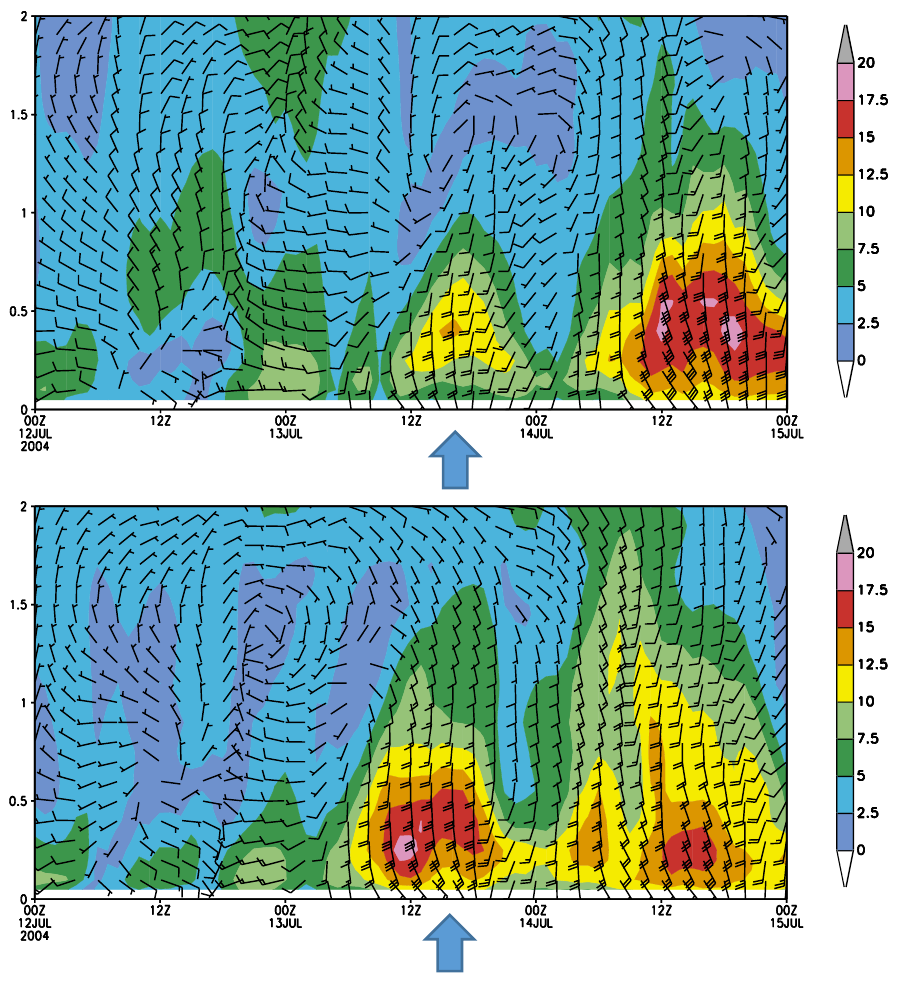
Figure 6. WRF model simulation of the gulf surface at Puerto Peñasco during NAME IOP 2 from native KF ( top ), and modified KF ( bottom ), presented equivalently the wind profiler observations as shown in Figure 5a. Blue upward pointing arrow below x -axis indicates the approximate timing of the observed gulf surge.